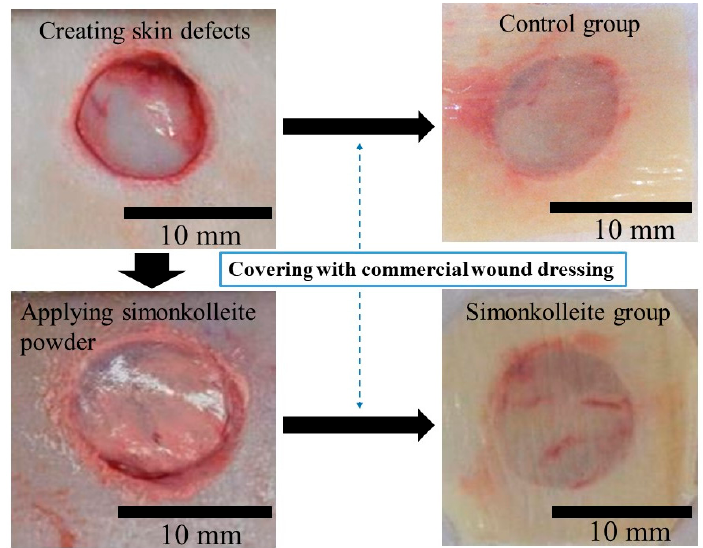
Figure 1. The application status of simonkolleite powder and wound dressings in each group.